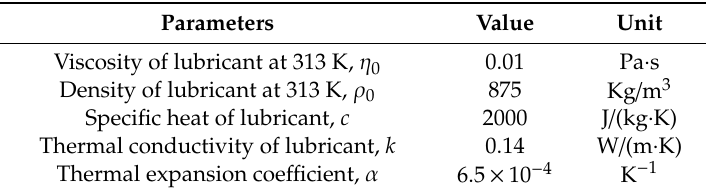
Table 4. The lubricant rheological